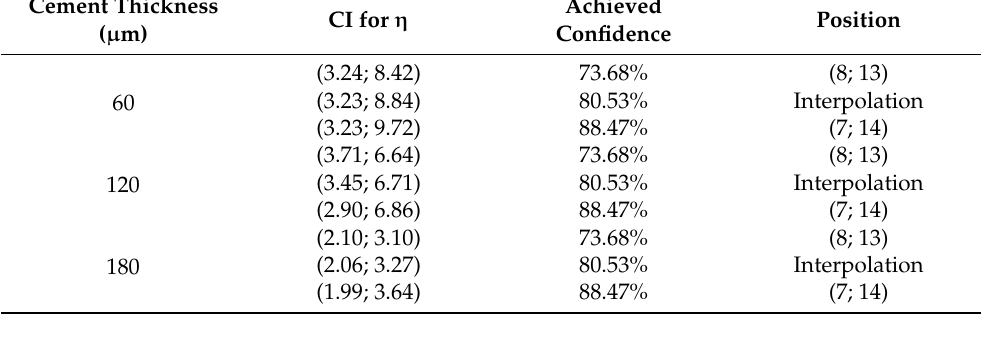
Table 5. Confidence intervals, achieved confidence and data position according to the cement layer thickness for aged groups.